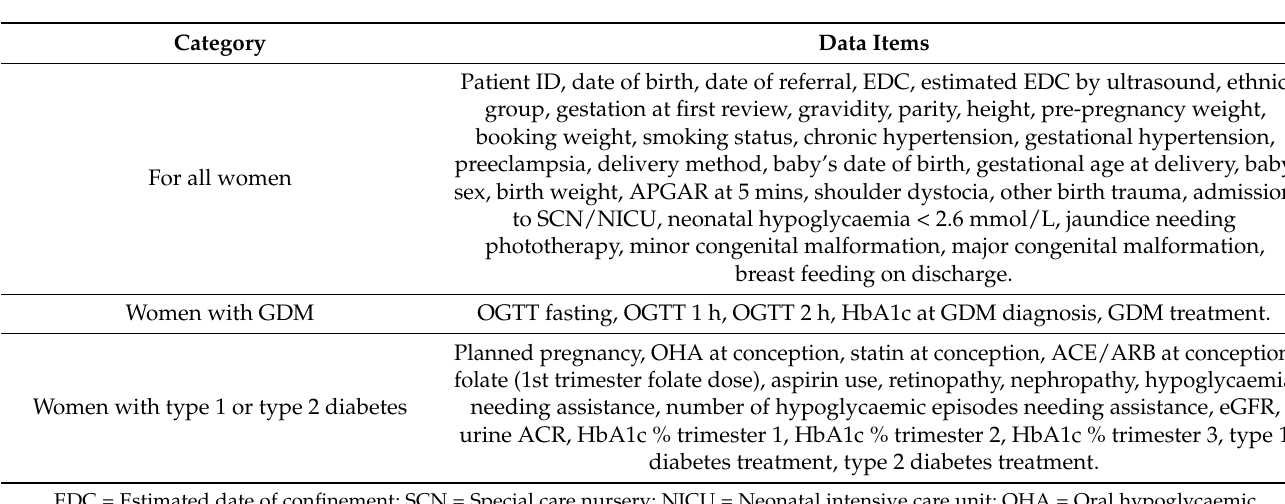
Table 2. Final audit tool